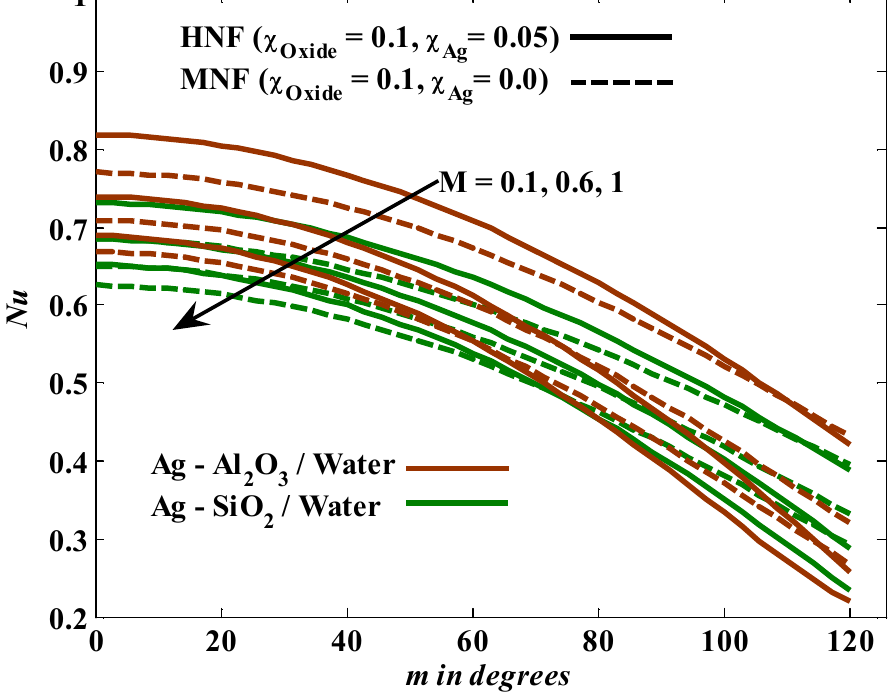
Figure 8. Illustration of M versus Nusselt number at fixed values of We = 0.2, λ = 0.1, & R =